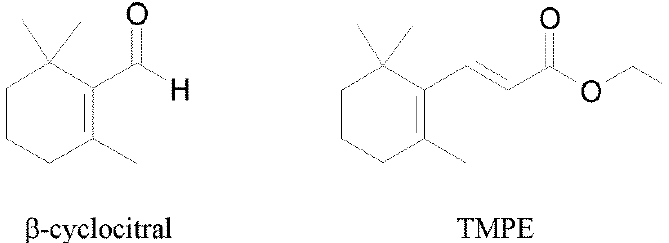
Figure 1. Chemical structures of β -cyclocitral and ethyl 3-(2,6,6-trimethylcyclohex-1-en-1-yl) prop-2-enoate (TMPE).